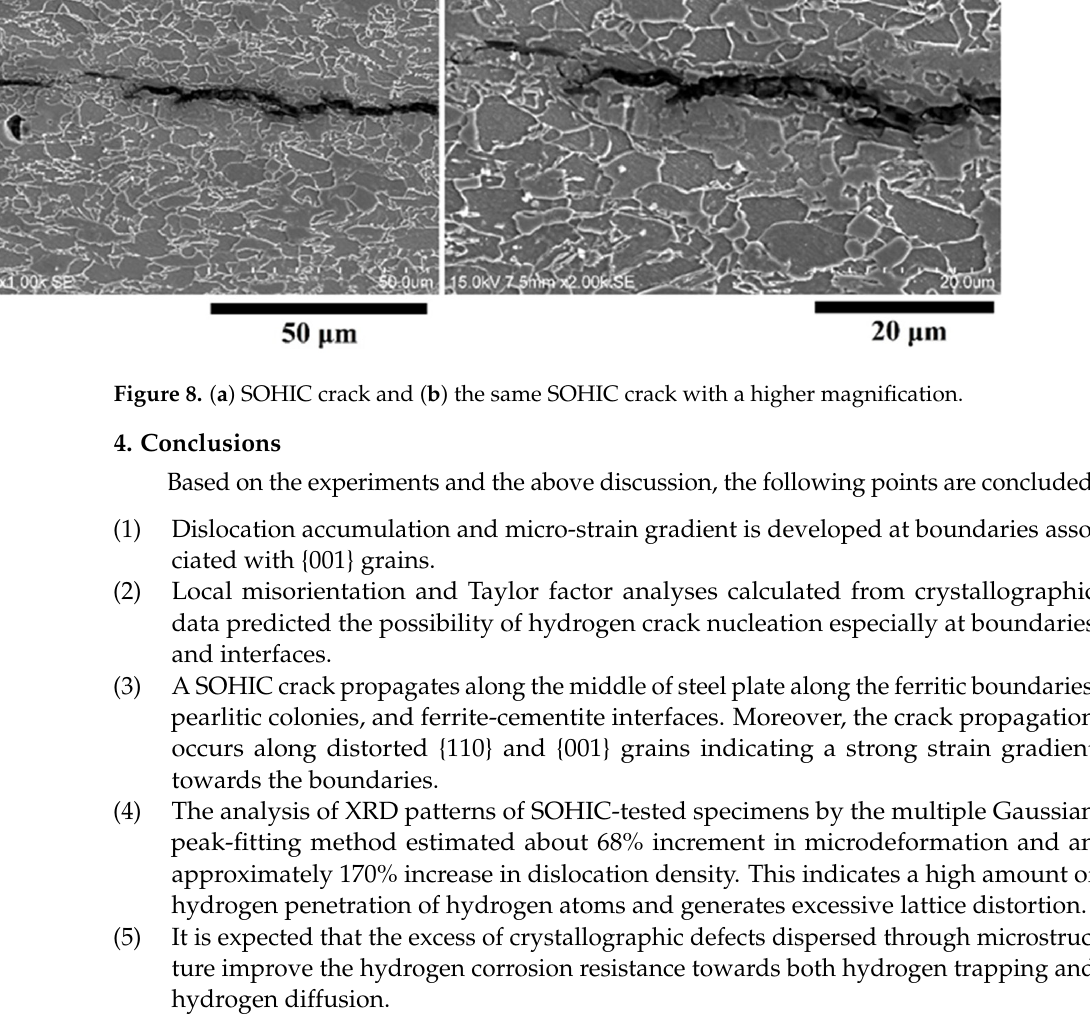
Figure 7. Comparison of ( a ) point-to-point misorientation and ( b ) Kernel average misorientation data of the EBSD data before and after the SOHIC test .